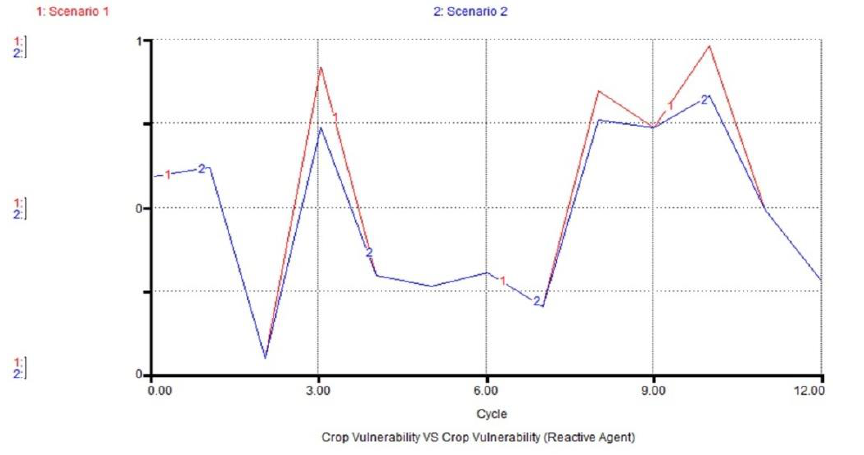
Figure 13. Crop vulnerability vs crop vulnerability (reactive agent).